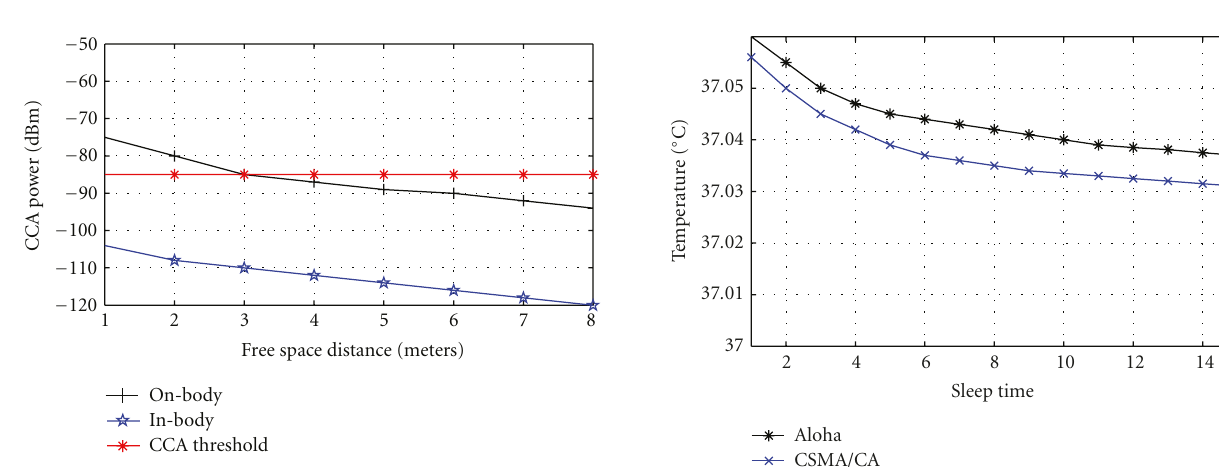
Figure 8: Saturated temperature using aloha and CSMA/CA.